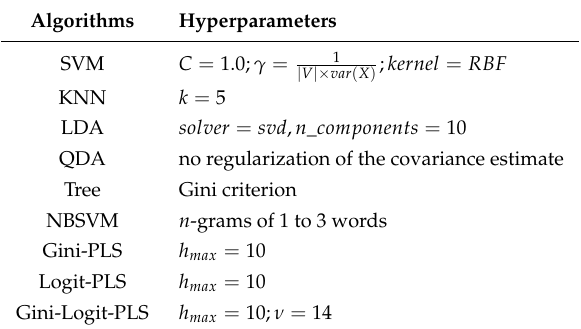
Table 7. Values of the hyperparameters of the algorithms.